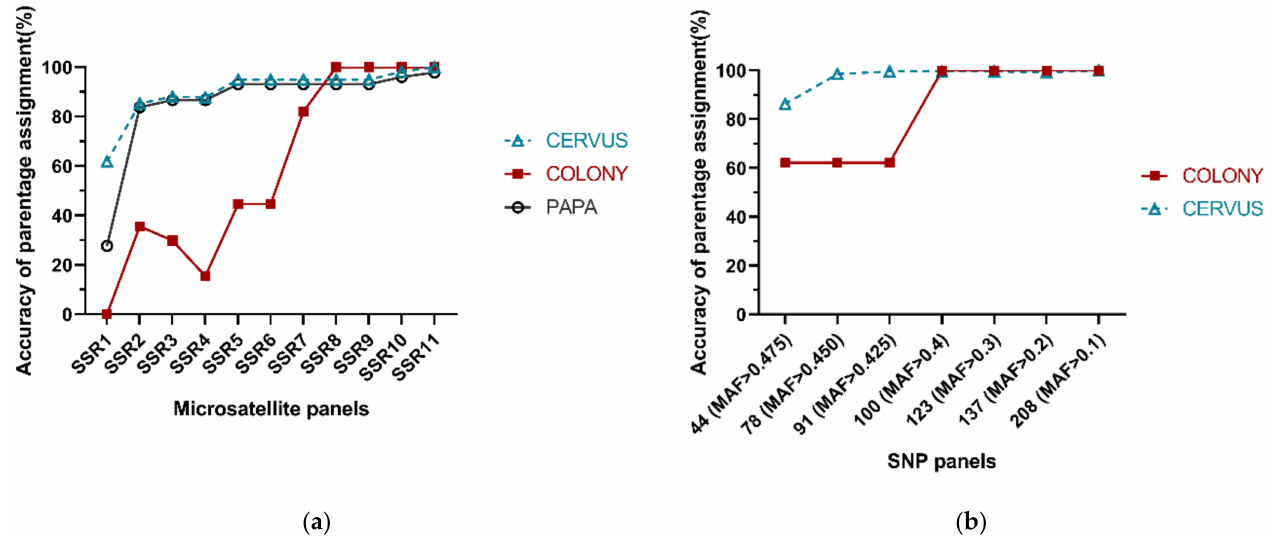
Figure 2. Accuracy of parentage assignment using differently sized microsatellite ( a ) and SNP ( b ) panels in different analysis programs. The accuracy was defined as the consistency derived from different marker panels compared with ‘standard